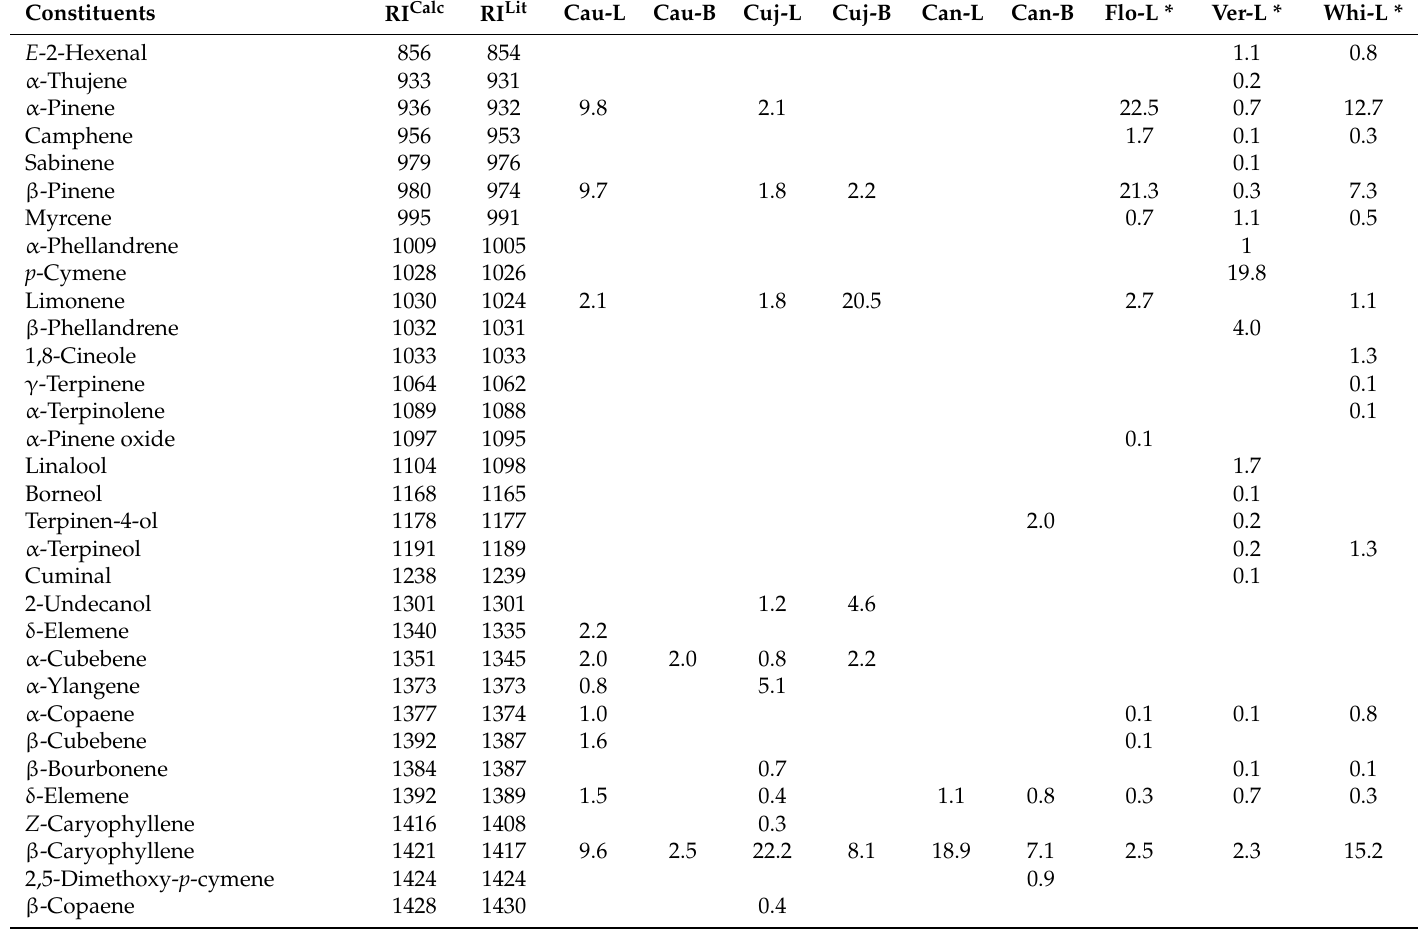
Table 2. Chemical composition of essential oils of Ocotea species. RI Calc , calculated retention index; RI Lit , literature retention